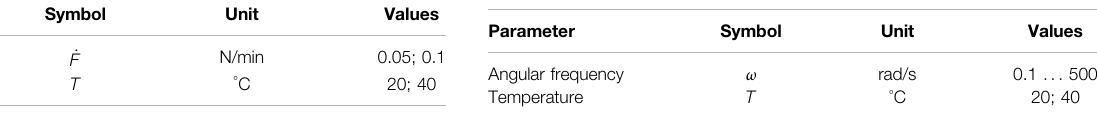
TABLE 4 | In-plane shear modulus — test